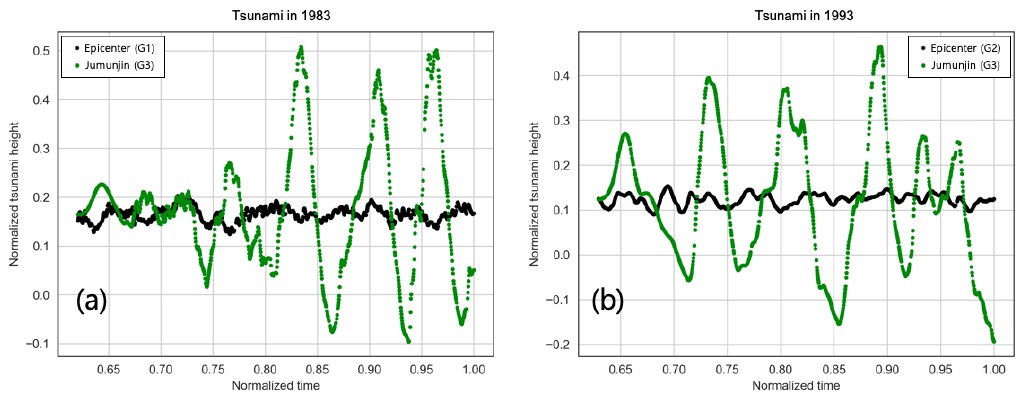
Figure 7. Training dataset of tsunami in ( a ) 1983 and ( b )